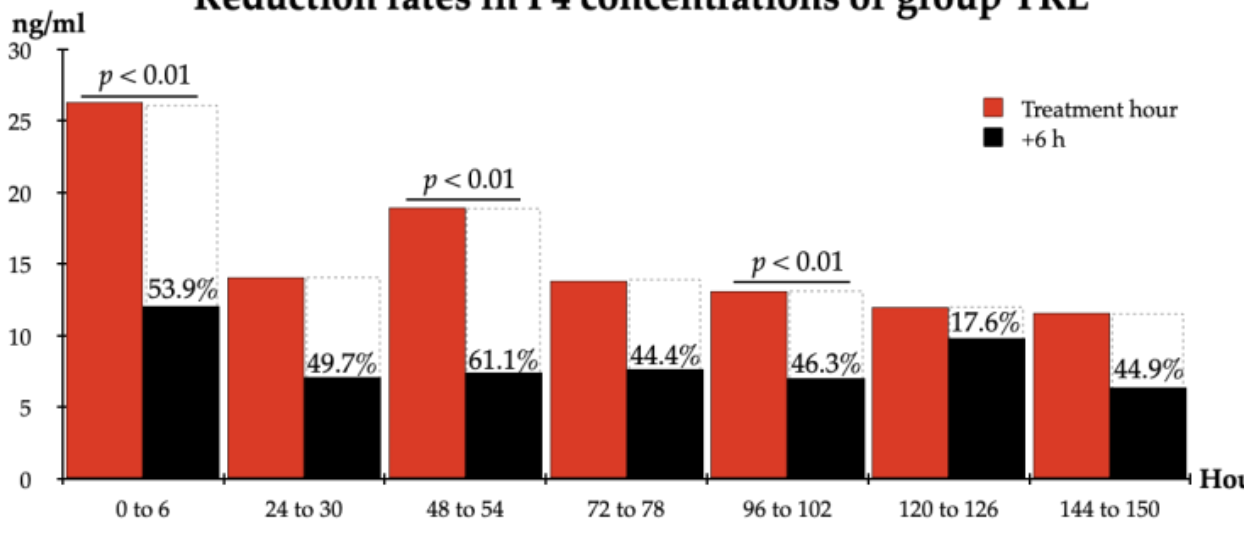
9 of 20 Figure 4. Serum P4 profiles for all groups. TRL: trilostane; AGL: aglepristone; CON: control. ( A ) and P4 concentrations for each of the groups ( B – D ). TRL and AGL treatment time indicated by dark blue